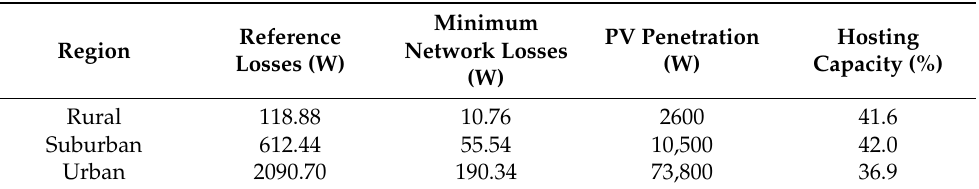
Table 9. PV penetration level at the minimum point of network losses for three regions for the balanced PV deployment scenario.